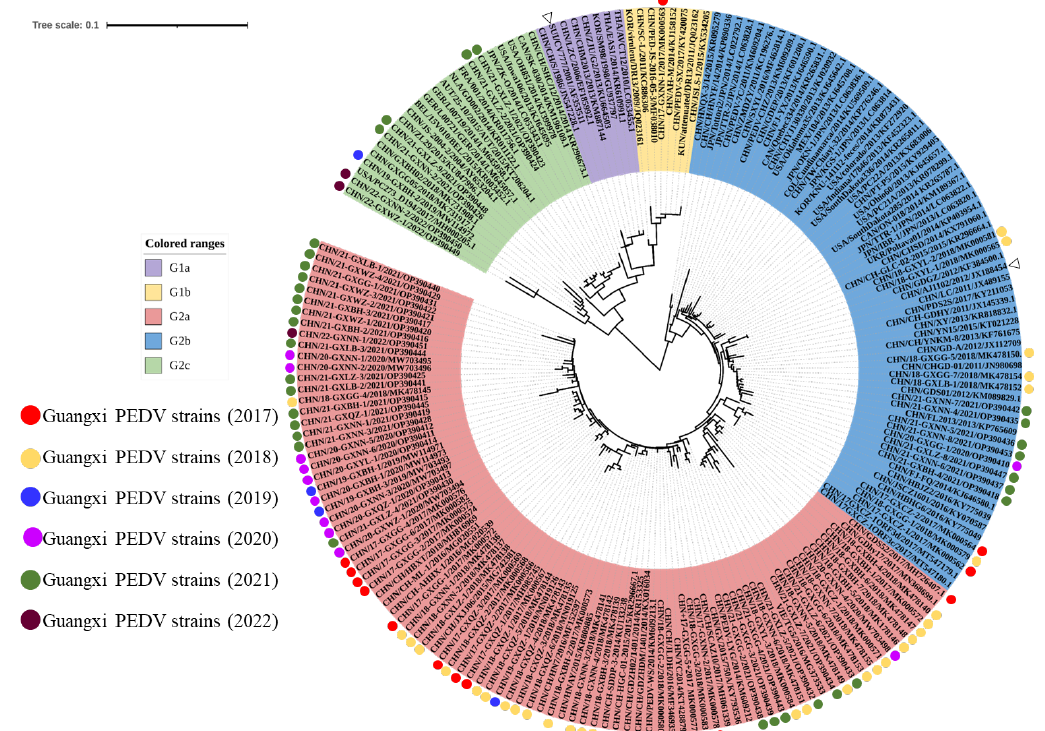
Figure 2. Phylogenetic analysis of the partial S1 gene sequences of 98 PEDV strains collected in this study, with 101 global reference strains. The tree was constructed using the neighbor-joining method for 1,000 replications in MEGA X software. Clades of different genogroups were colored as follows: G1-a (light purple), G1-b (light yellow), G2-a (light red), G2-b (light blue) and G2-c (light green). The strains reported in this study and the representative reference strains from each genogroup are highlighted in circles of different colors depending on the year and the hollow triangles. Table 2. Homology analysis of the practical S1 gene of 98 PEDV strains collected in this study as well as 2 vaccine strains.